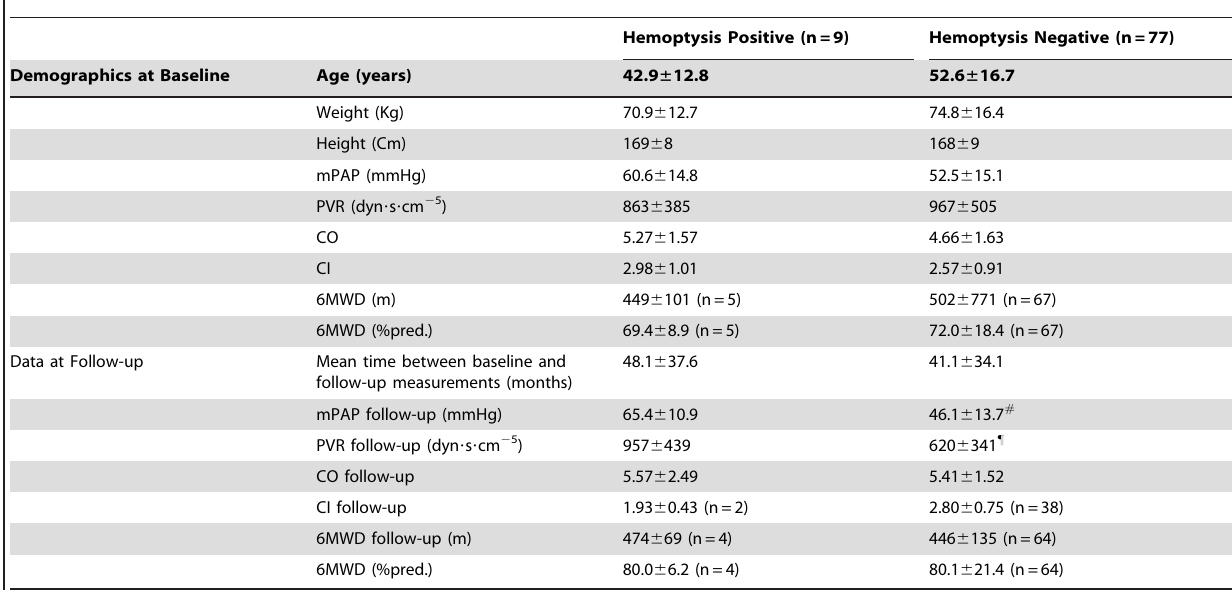
Table 3. Baseline and follow-up demographics and hemodynamics of the study population in which follow-up data was available.